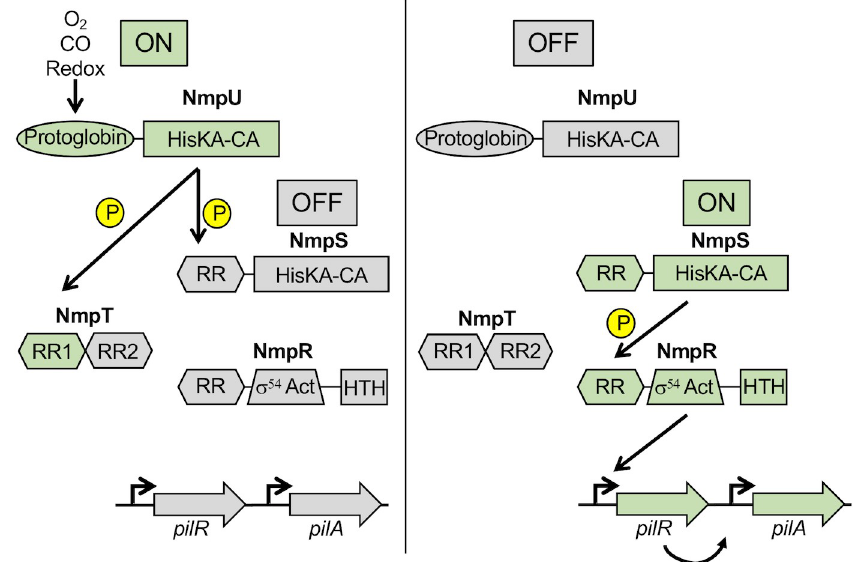
Fig 9. Model of the NmpRSTU multi-component signaling pathway. The presence of oxygen is sensed by the protoglobin domain of the SK NmpU. During high oxygen conditions, NmpU is “on”, autophosphorylating and subsequently phosphorylating the receiver domain of the hybrid RR-SK NmpS. We propose this would maintain NmpS in an “off” state. Additionally, the first receiver domain of NmpT serves as a phospho-sink for NmpU. When oxygen is limiting, perhaps in certain soil types/depths or during multi-cellular development, NmpU switches to an “off” state, leading to the loss of phosphorylation of NmpS and turning “on” the second branch of the pathway. NmpS phosphorylation of the RR NmpR under these conditions activates NmpR leading to modulation of the expression of pilR , which in turn regulates pilA expression influencing T4P-dependent